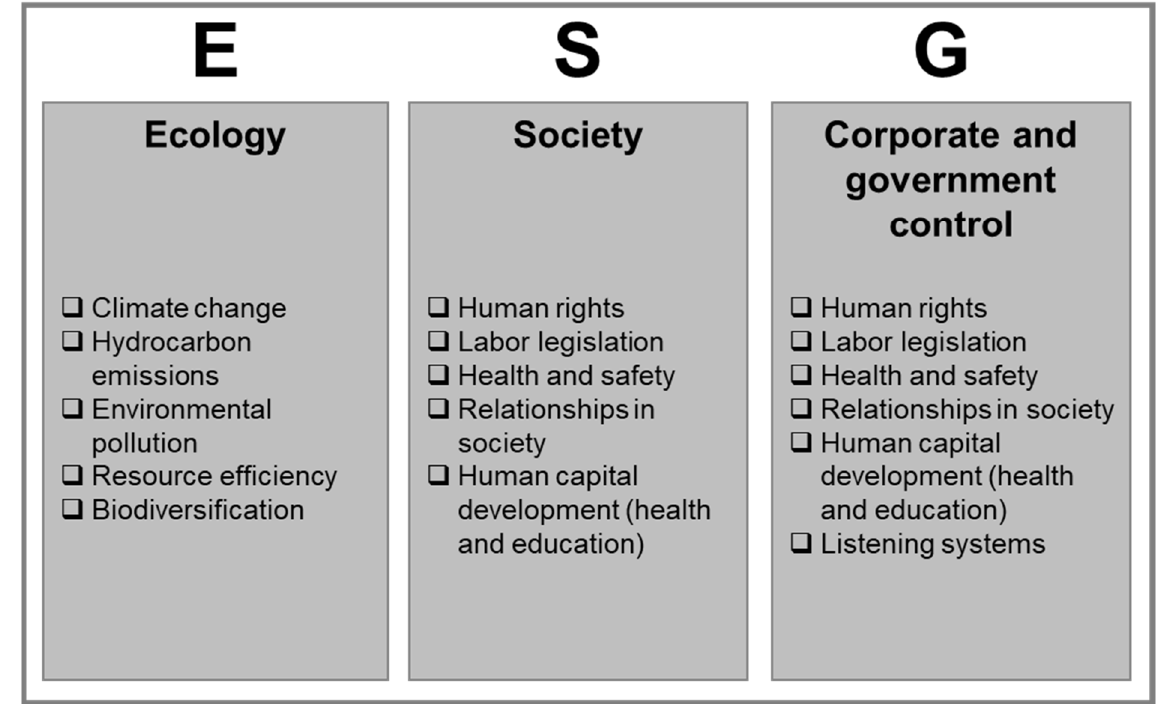
Figure 4. ESG overview (source: Antea Group and Oil & Gas 360, 2020).